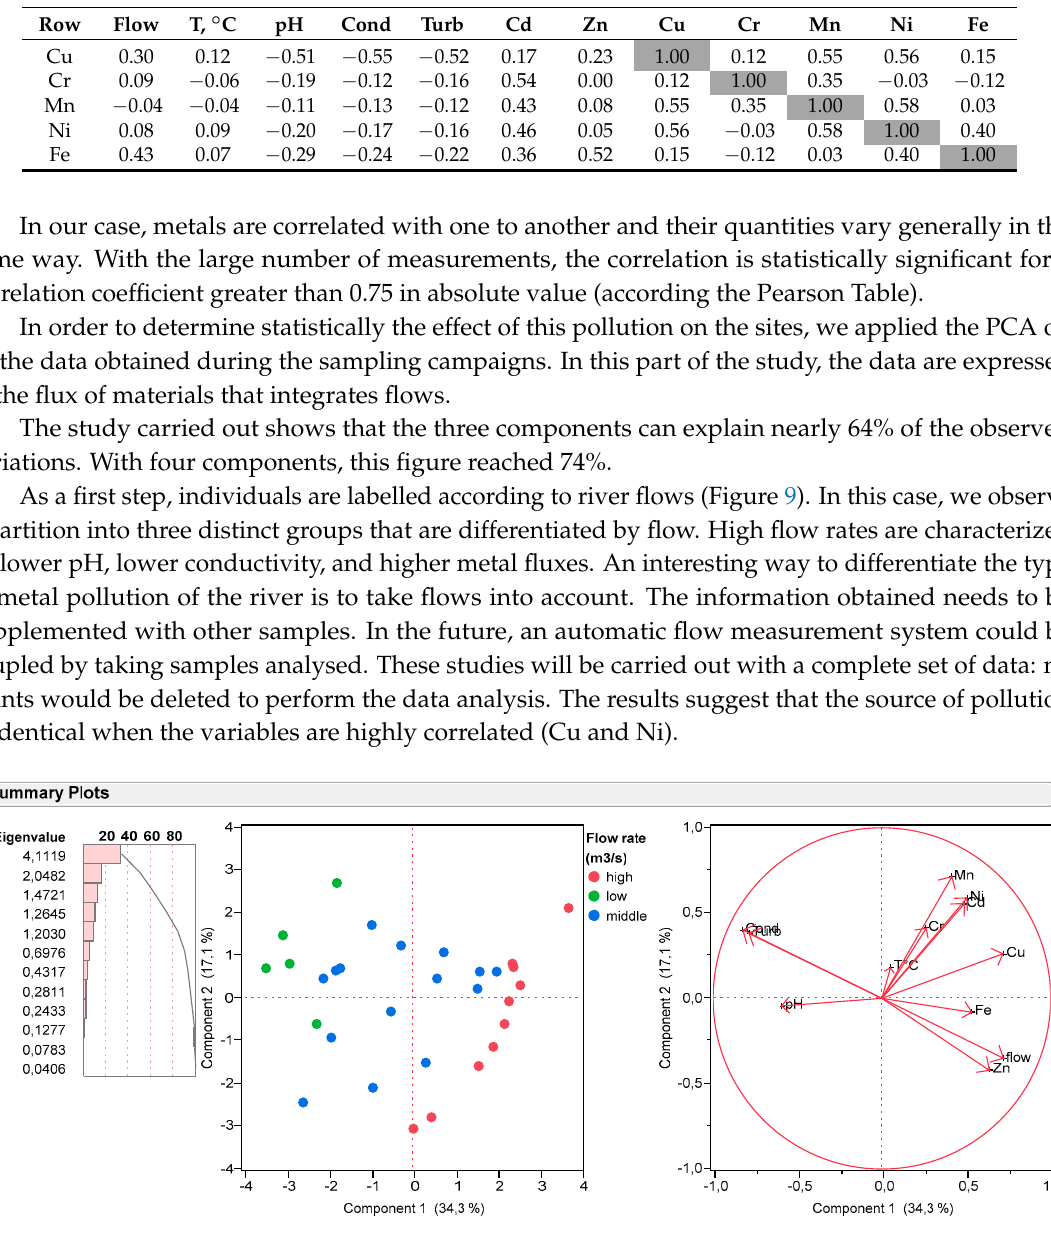
Figure 9. Summary plot scores and loadings plot.